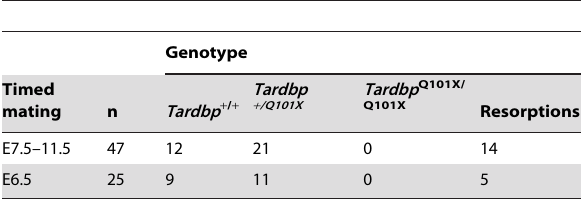
Table 1. Tardbp Q101X/Q101X embryos die in development before E6.5.